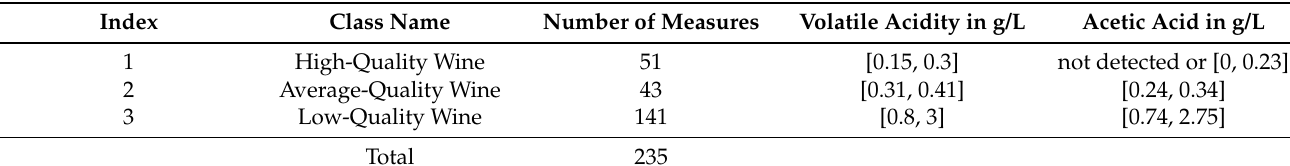
Table 2. Number of measures in wine of the EN dataset #2.